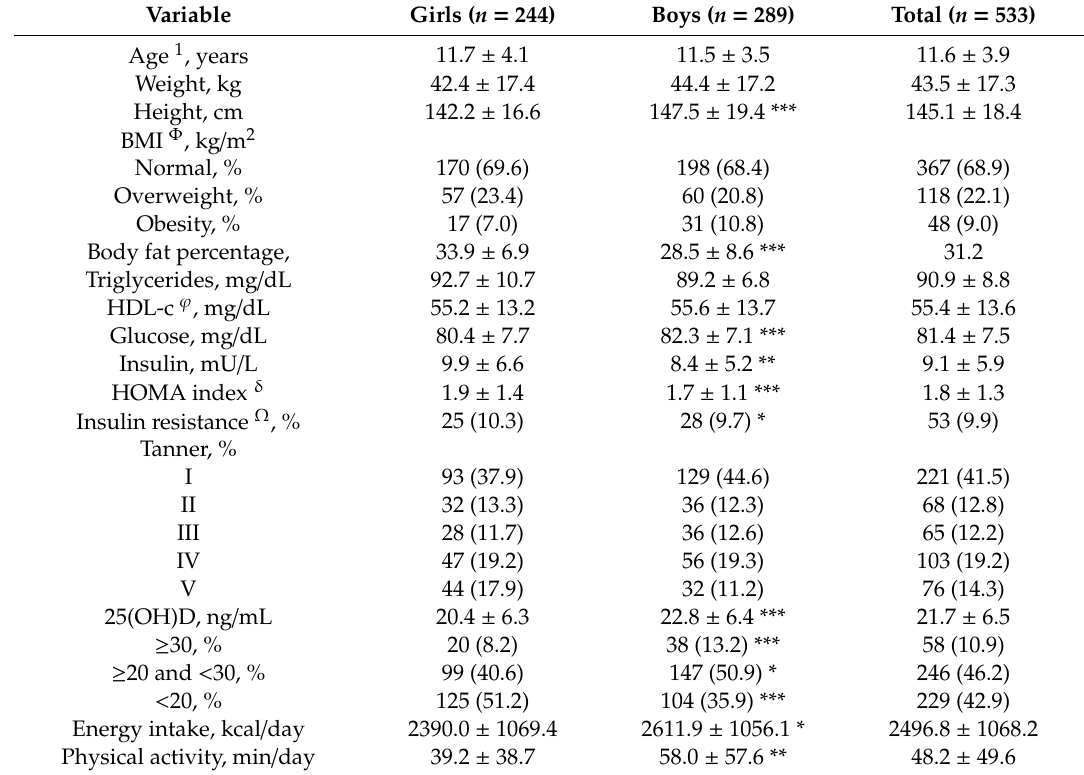
Table 1. Characteristics of the study population, by